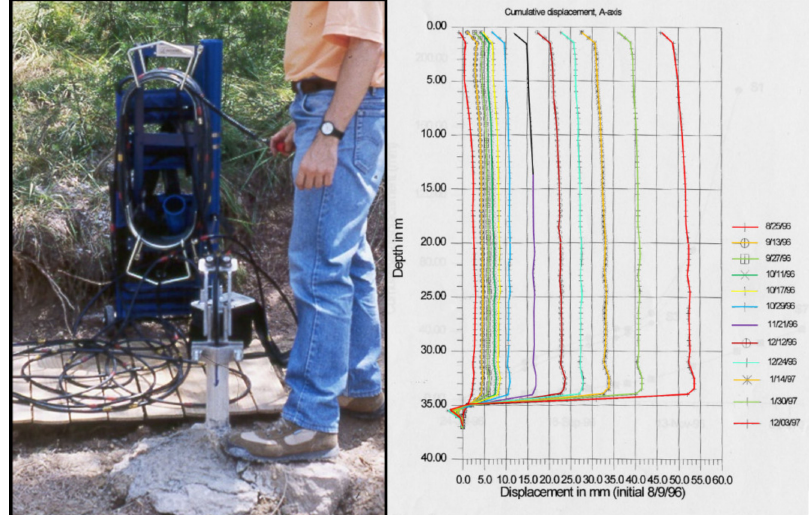
Figure 11. Left : view of the head of a borehole during the measurement with the inclinometer. Right : graph with the successive displacement profiles from August 1996 to December 1997. The main slip surface appeared to be 34 m deep. The pretty constant deformation profile corresponds with a translational